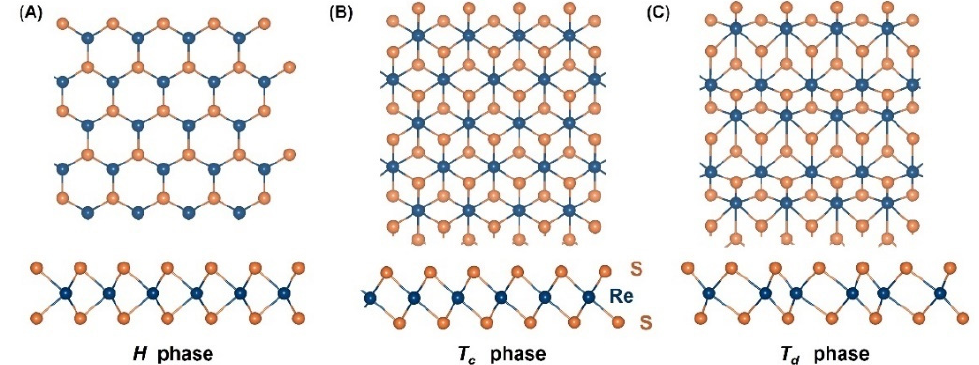
Figure 2. Top and side view of single-layer crystal structures of ( A ) H phase, ( B ) T c phase, and ( C ) T d phase.